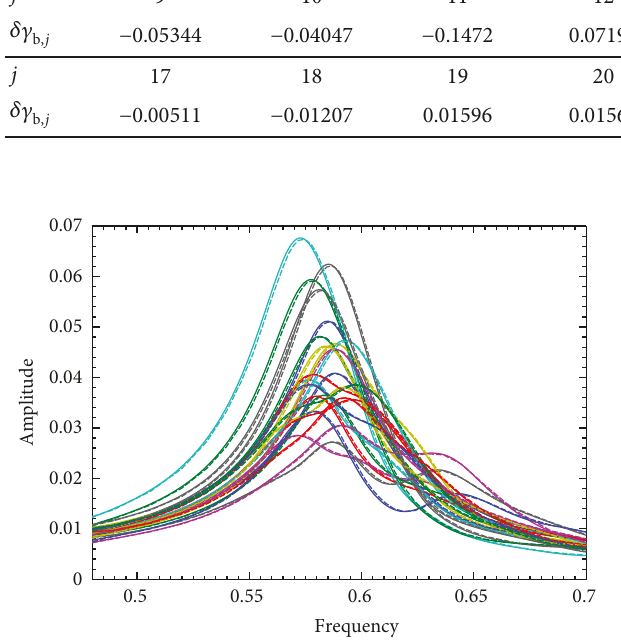
Figure 9: Forced response of the mistuned blisk with SSDNC (solid curves: NCMS method; dash curves: MHBM-AFT).